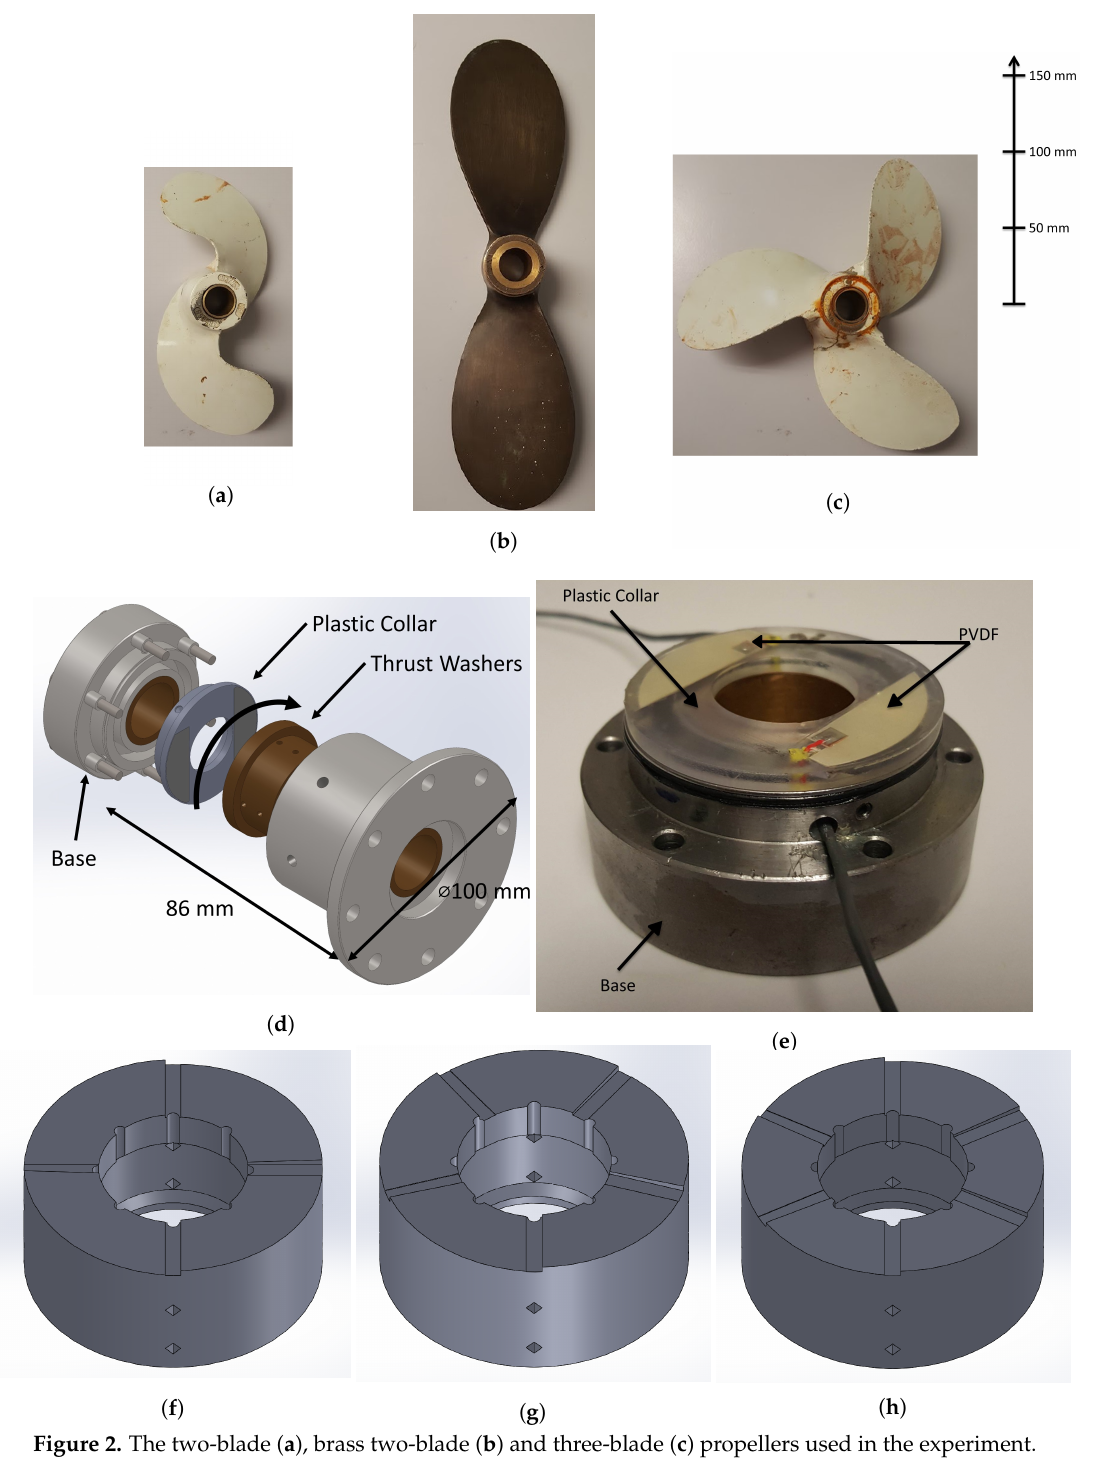
Figure 2. The two-blade ( a ), brass two-blade ( b ) and three-blade ( c ) propellers used in the experiment. ( d ) Assembly drawing of the thrust bearing. ( e ) The thrust bearing washer with embedded PVDF film. The four ( f ), five ( g ) and six ( h ) pad bearings